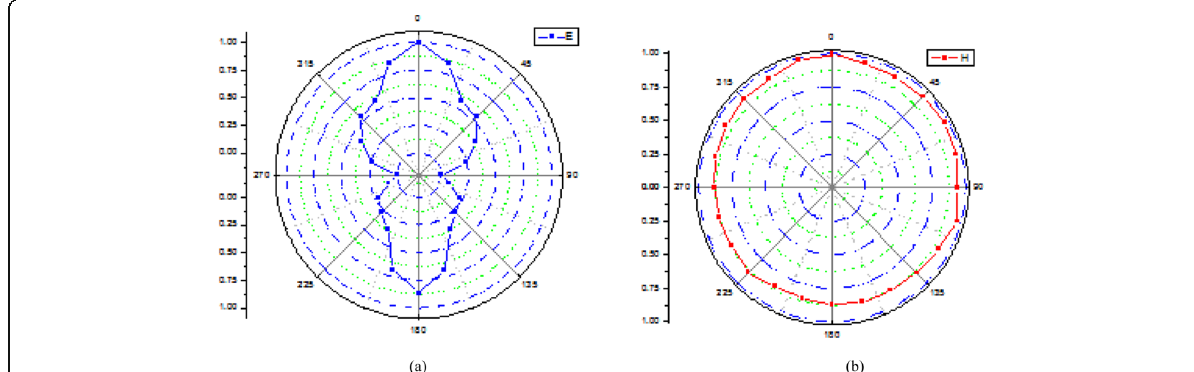
Fig. 9 Experimental test result of time-domain directional diagram of single receiving antenna. a Test result of pulse signal source in E-plane directional diagram. b Test result of pulse signal source in H-plane directional diagram